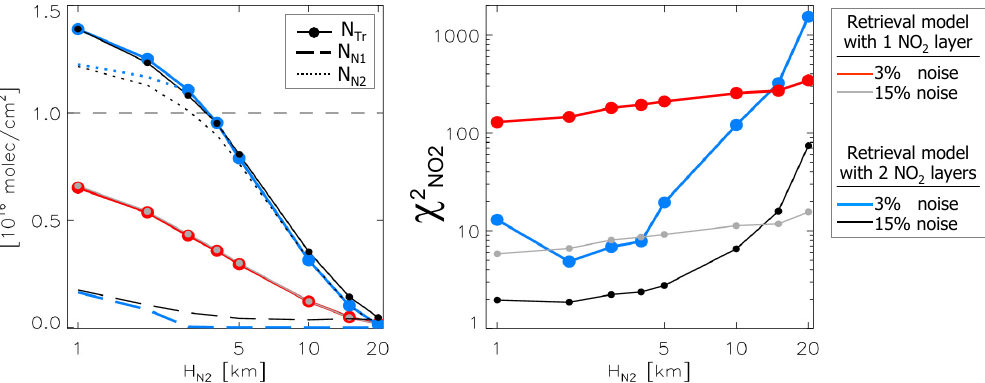
Fig. 10. Sensitivity study F (elevated NO 2 layers). On the left partial and total NO 2 columns are shown for both the one and two NO 2 layer retrieval model, for two noise levels. On the right χ 2 values are shown for both models and noise levels. The elevated NO 2 layer NO 2 in this experiment had a partial NO 2 column of 1 . 0 × 10 16 moleccm − 2 . Note that height of the elevated NO 2 layer ( H N 2 ) is varied in this sensitivity study, whereas it is fixed in the two NO 2 layer retrieval model, see Sect.